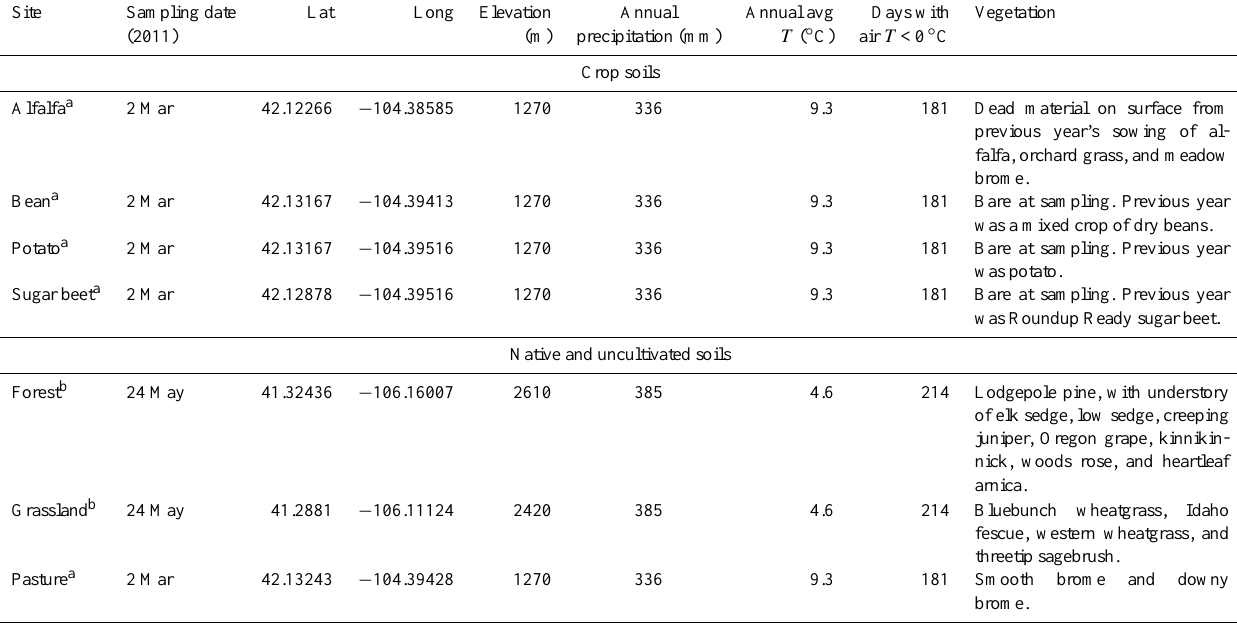
Table 1a. Description of sampling sites.